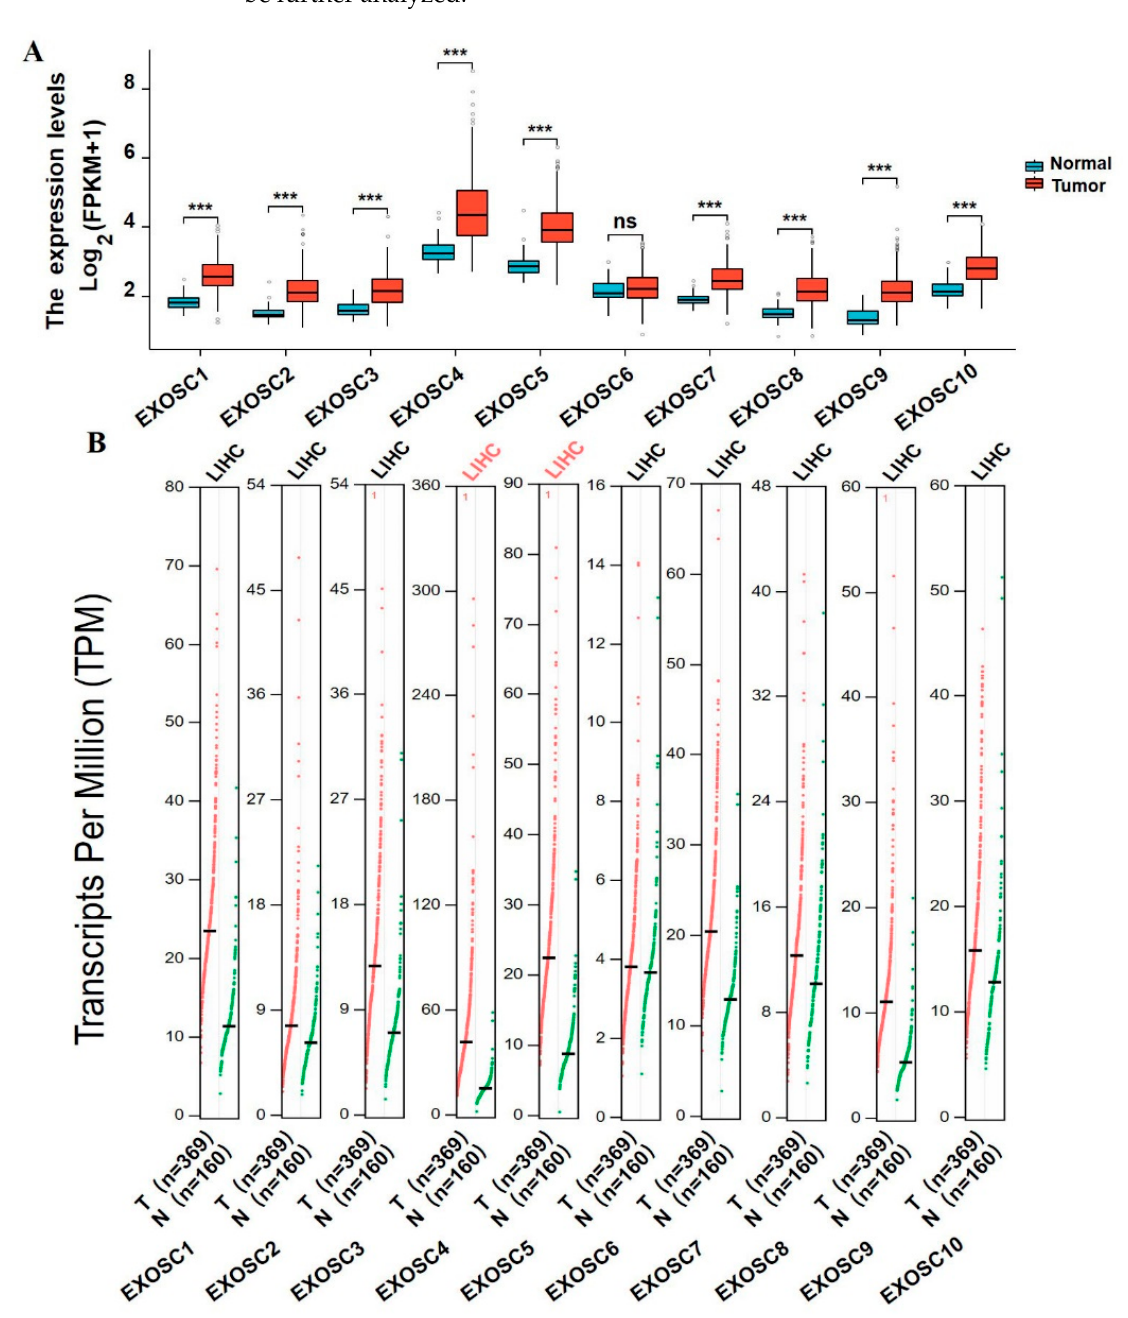
Figure 1. The mRNA expression of EXOSCs in HCC tumor and normal tissues. ( A ) The transcriptional levels of all members in EXOSCs (EXOSC 1–10) from TCGA database. ( B ) The mRNA expression of EXOSCs from GEPIA dataset. *** p < 0.001.